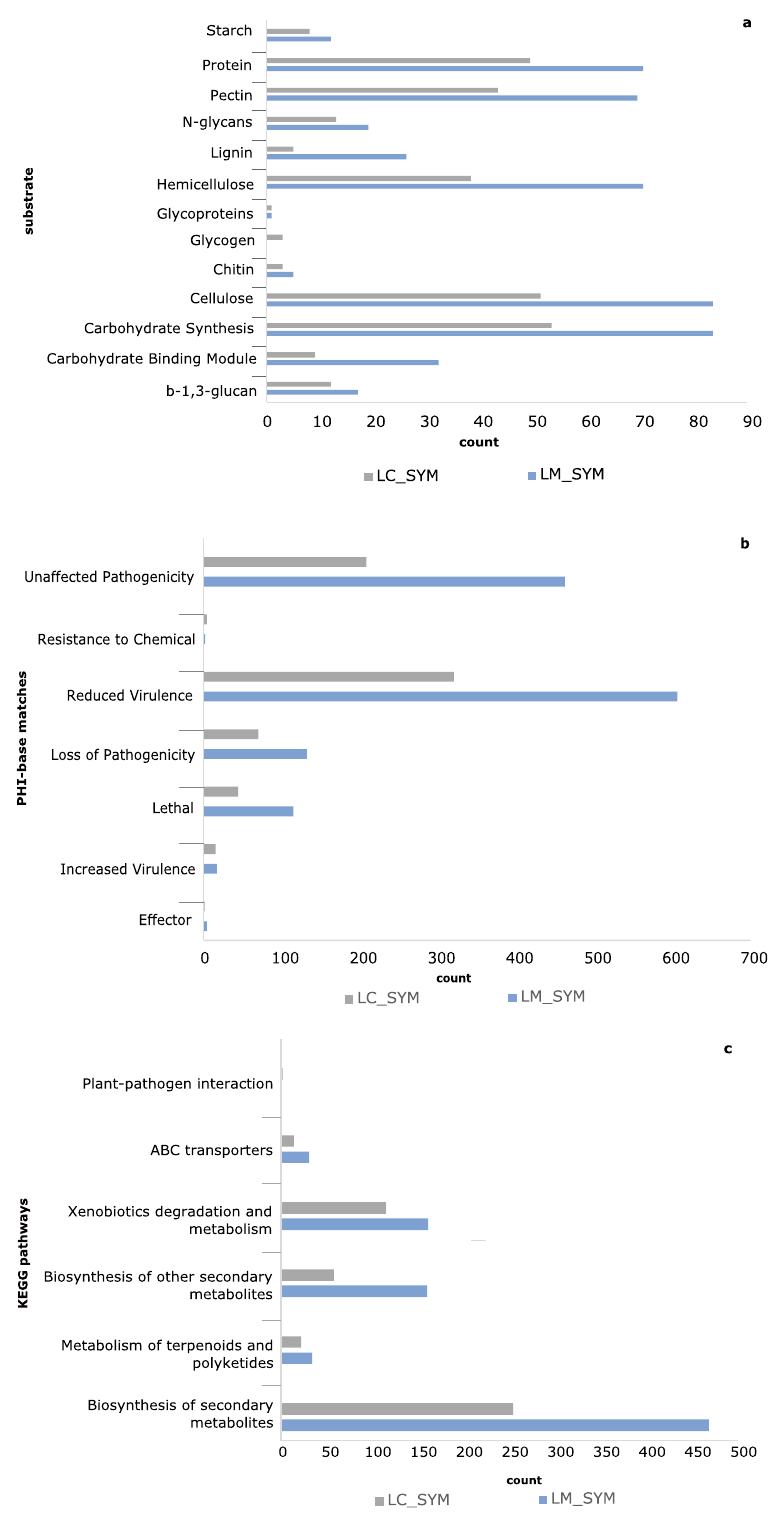
Figure 5. Number of differentially expressed (DE) fungal transcripts annotated as ( a ) enzymes that degrade proteins and various substrates, ( b ) genes important to pathogenicity, and ( c ) metabolic pathways in needles symptomatic of Lophodermella concolor (LC) and L. montivaga (LM) in comparisons LC_ASYM vs. LC_SYM and LM_ASYM vs. LM_SYM, respectively; in these two comparisons, no fungal DE transcripts in asymptomatic needles. Annotations were inferred from dbCAN2 and PFAM, PHI-base and KEGG,